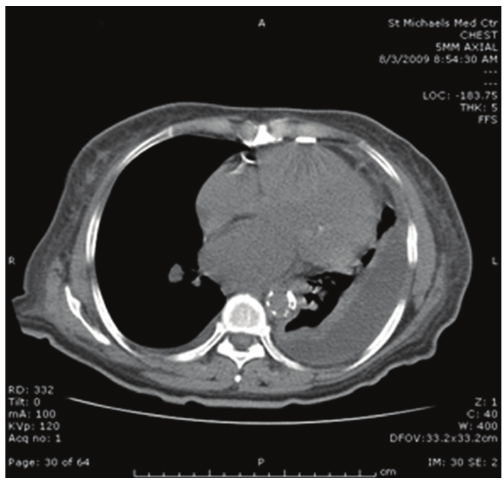
Figure 2: CT scan of the chest showing a large left pleural e ff usion with